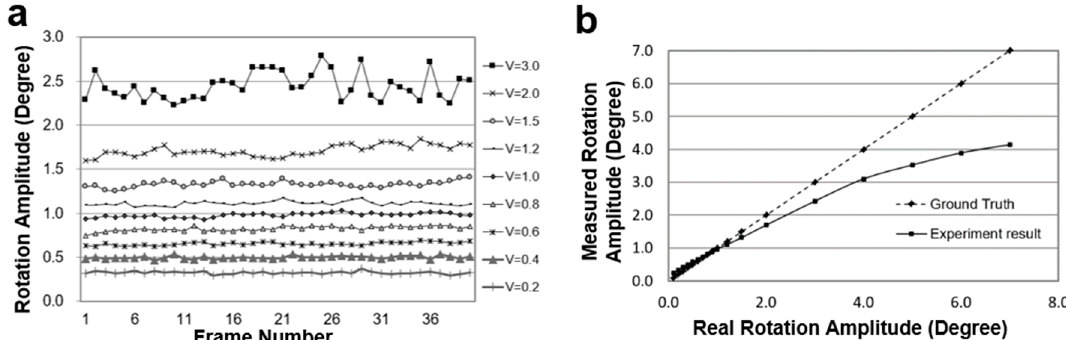
Figure 9. Test results on the animated rotating Earth globe. ( a ) The calculated rotation amplitude of the Earth globe in different image sequences. On the right-side of this figure, ‘ V= ’ represents the velocity (ground truth; unit: degree/frame) of the rotating Earth globe; and ( b ) the comparison of the calculated rotation amplitude with the ground truth of the Earth globe’s rotation.